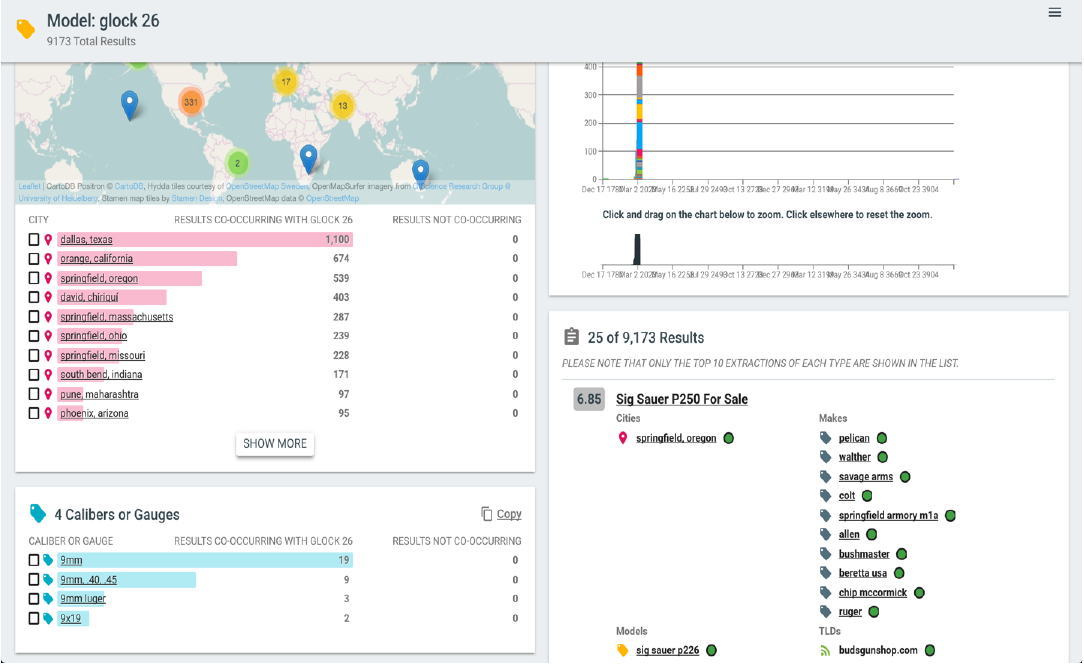
Figure 6. Entity-Centric Search (ECS) for the illegal firearms sales domain in